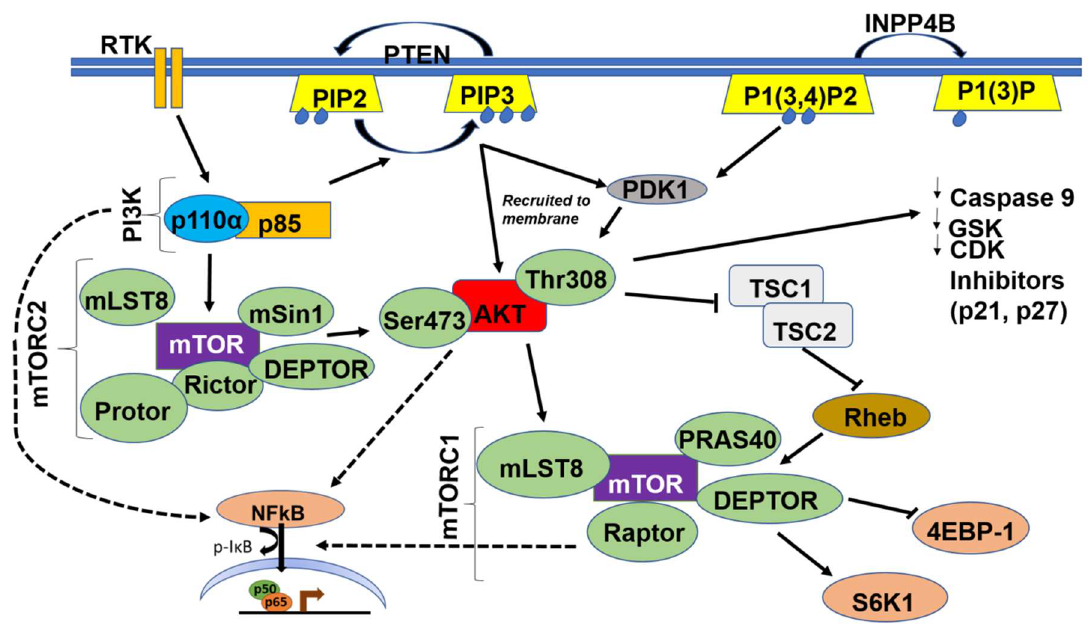
Figure 2. Schematic illustration of the PI3K / AKT / mTOR / NF κ B Pathway. Dashed arrows indicate indirect activation of nuclear factor- κ light chain enhancer of activated B cells (NF κ B) by PI3K, AKT and mTOR.